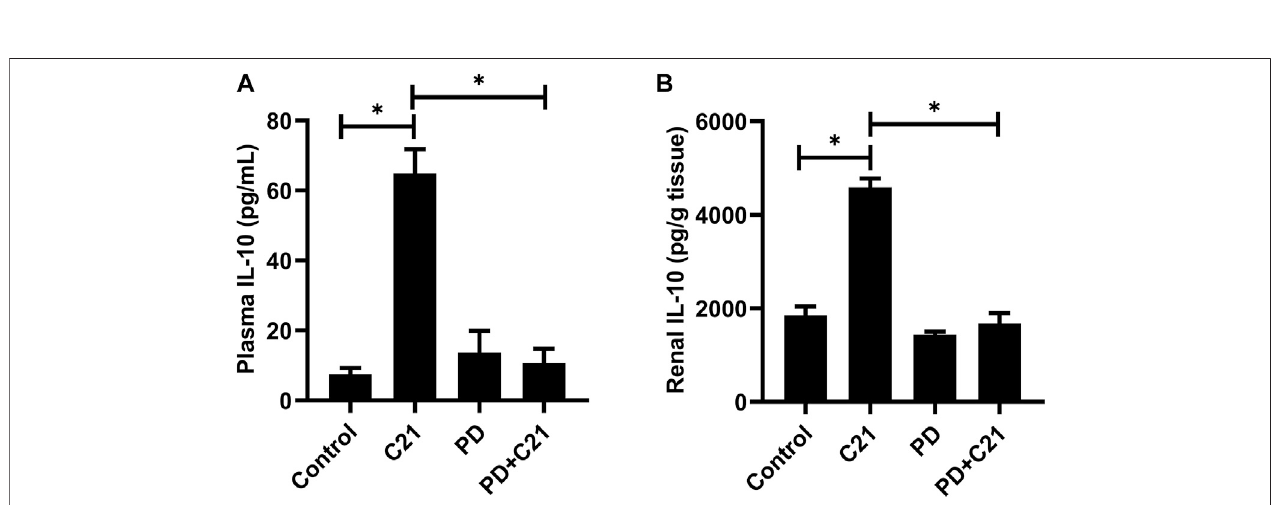
FIGURE 2 | Inhibition of the anti-in fl ammatory effect of C21 by AT2R antagonist PD in the (A) plasma and (B) kidney of C57BL6/NHsd mice. Data are represented as Mean ± S.E.M., analyzed by one-way ANOVA with Fisher ’ s LSD test for multiple comparisons and are considered signi fi cant at * p < 0.05.